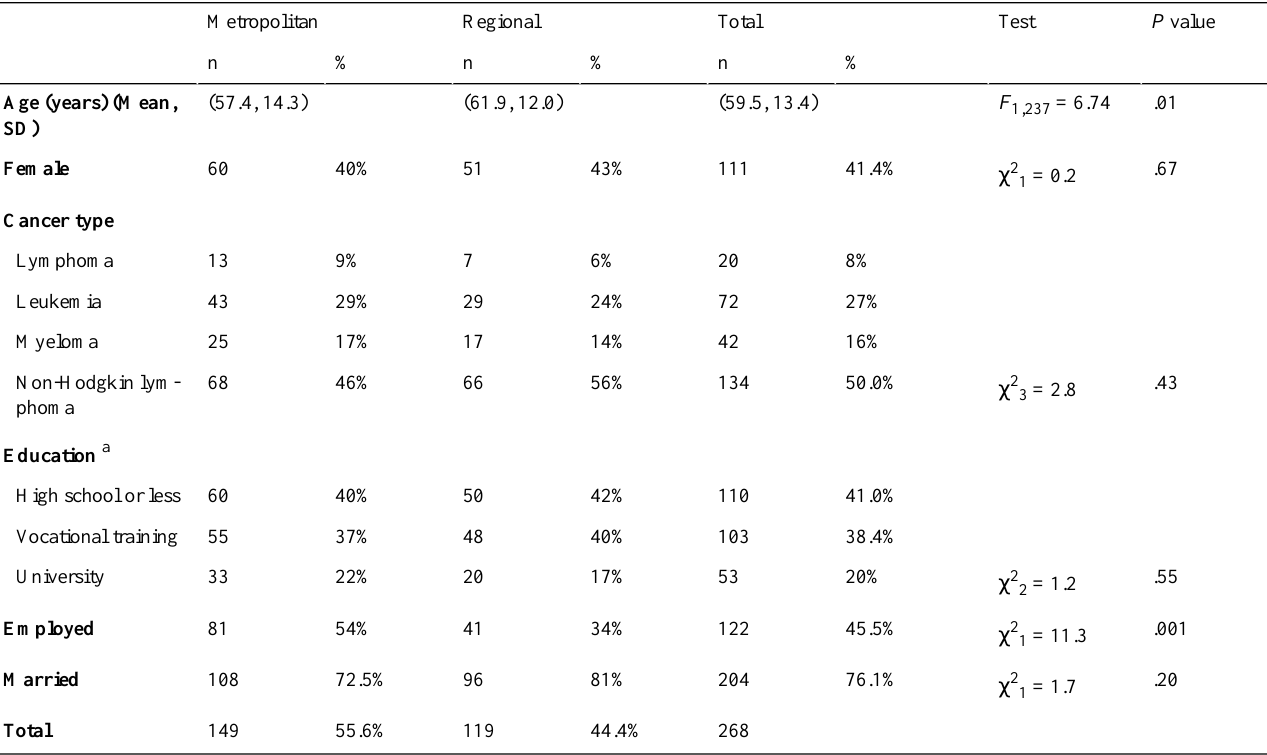
Table 1. Sociodemographic characteristics of the sample calculated for those living in a major city or regional area at the time of the survey (n = 268)